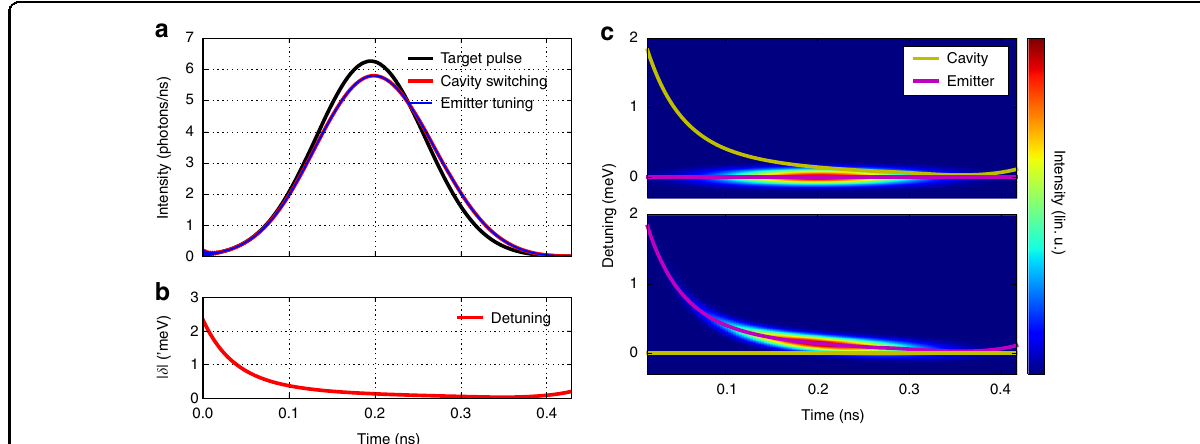
Fig. 7 Modelling the generation of single photons with Gaussian temporal envelope. a Single photon temporal envelopes for the target Gaussian-pulse with 150 ps FWHM (black line) and pulses emitted by a realistic QD – cavity system using ultrafast emitter tuning (blue line) or cavity switching (red line). The QD is ideally located at the antinode of a photonic crystal cavity characterized by Q = 7000, F p = 80 and γ nr = 0.05. b Time- dependence of the detuning that is used to generate these single-photon pulses. c Time-resolved spectrum calculated using quantum Langevin equation for single-photon pulses obtained using cavity switching (top) or emitter tuning (bottom). A pronounced chirp is observable for the emitter-tuning